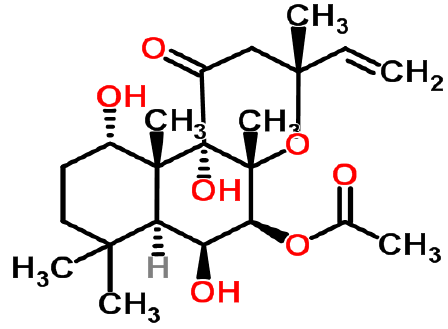
Figure 1. Chemical structure of forskolin.